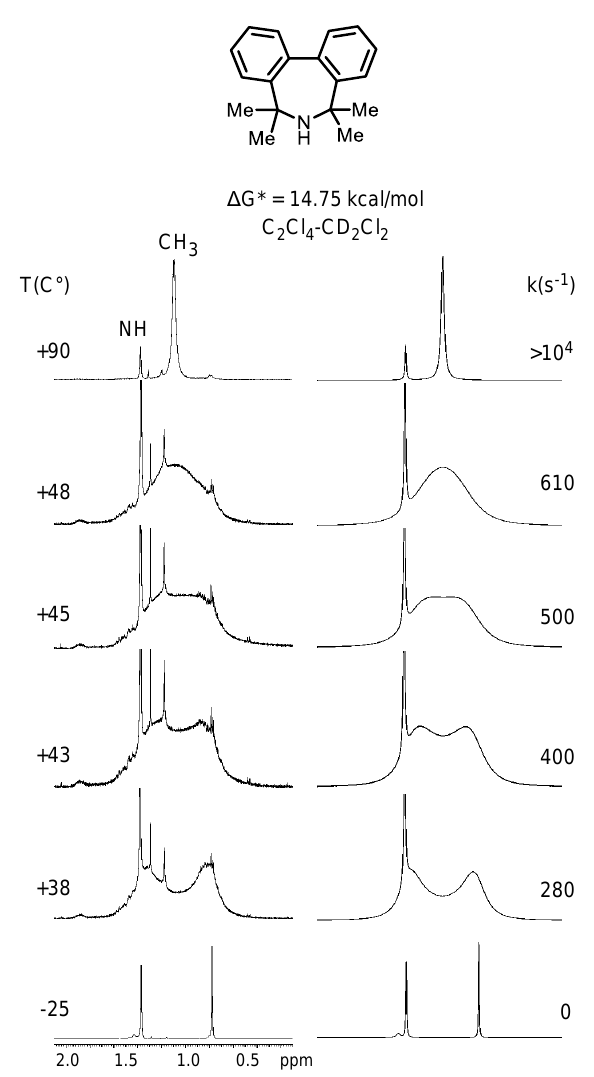
Figure 2. 1 H NMR spectra at 500 MHz in C 2 Cl 4 -CD 2 Cl 2 for the signals of the two benzylic Me groups of biphenylazepine 2 . Experimental traces are shown on the left and the computer simulated ones on the right.